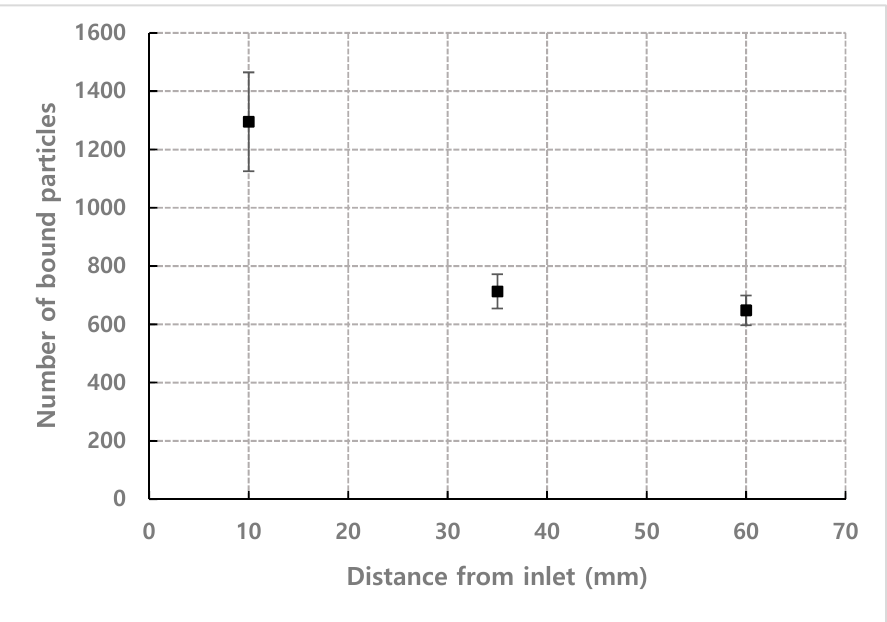
Figure 9. Number of bound particles depending on the distance of the observation position from inlet ( n = 1.93 × 10 14 m − 3 , τ = 1200 s, Flow late = 1.2 mL · h − 1 )